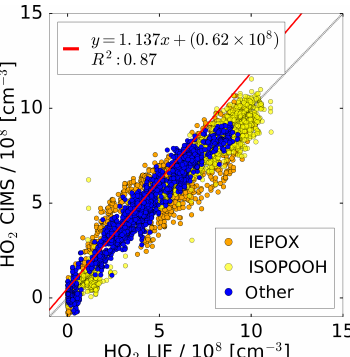
Figure 8. Correlation plot for the HO 2 concentrations measured by the CIMS and the LIF instrument of all photo-oxidation experi- ments in the SAPHIR chamber. A linear fit is applied to the subset of data excluding experiments with IEPOX and